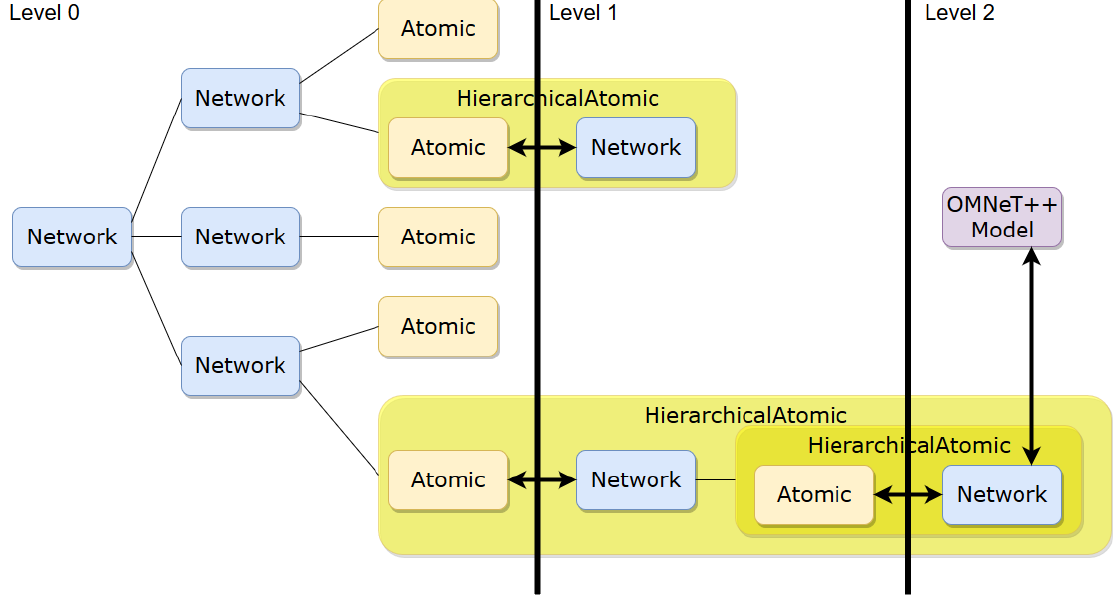
Figure 2. The model tree and organization of hierarchy